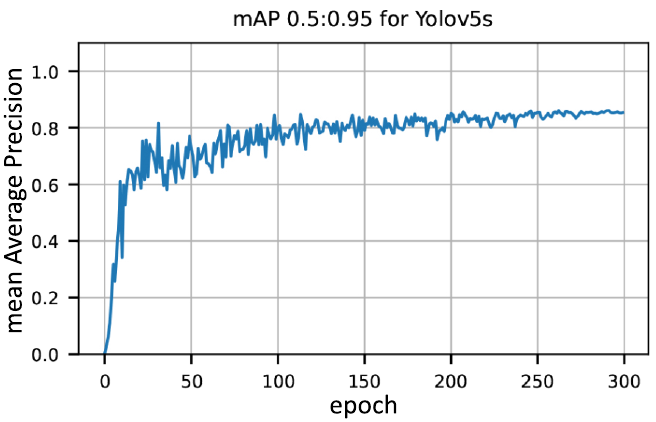
Figure 4. Mean Average Precision (mAP 0.5:0.95) for AirTender detection.